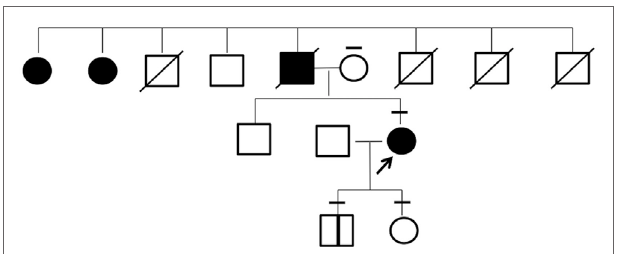
FIGURe 3 | pedigree of the investigated family . Individuals affected with goiter are indicated by filled symbols. The arrow shows the proband in this study. The bars above each symbol indicate individuals who underwent a sequencing analysis for KEAP1